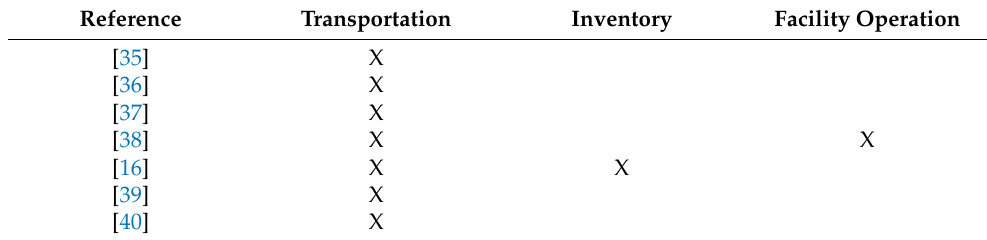
Table 4. Related work with regard to cost